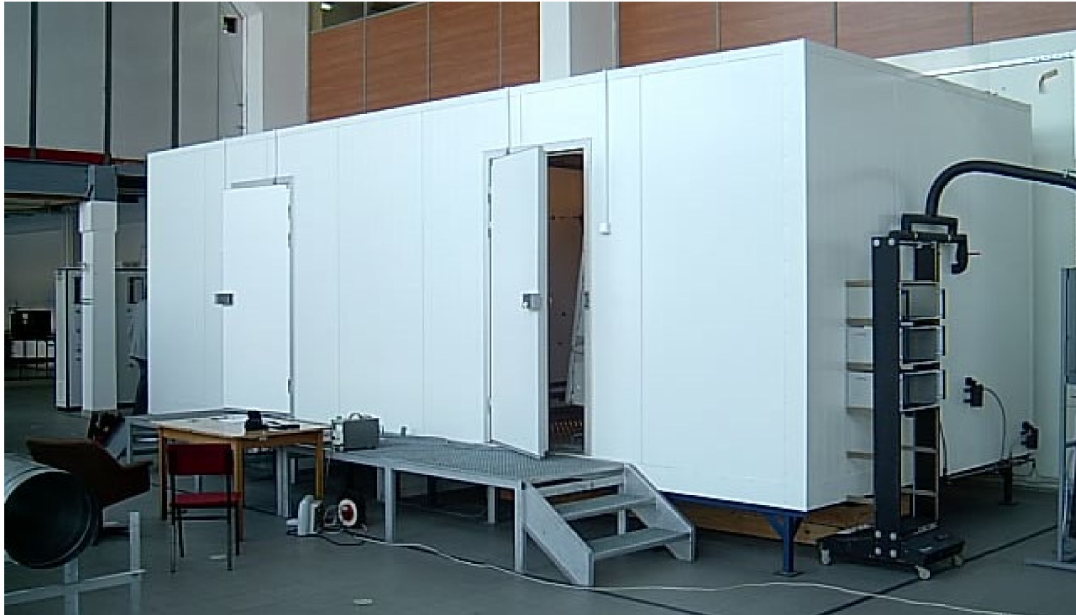
Figure 3. Full-scale climate chambers (cold chamber on the left and warm chamber on the